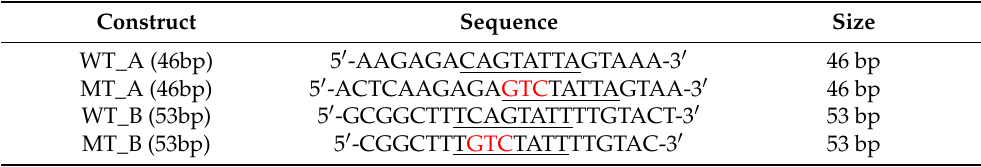
Table 2. The 3 (cid:48) UTR of DLC1 target site isolation and substitutional mutations. The underlined se- quence is the miR-200c-3p seed sequence, and the red sequence is the substitution mutation